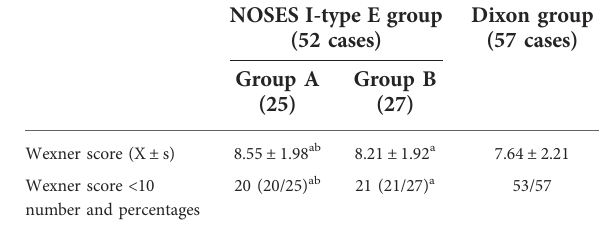
TABLE 6 Anal function score and the number and percentage of cases with scores less than 10 in the four groups at 1 year after operation.